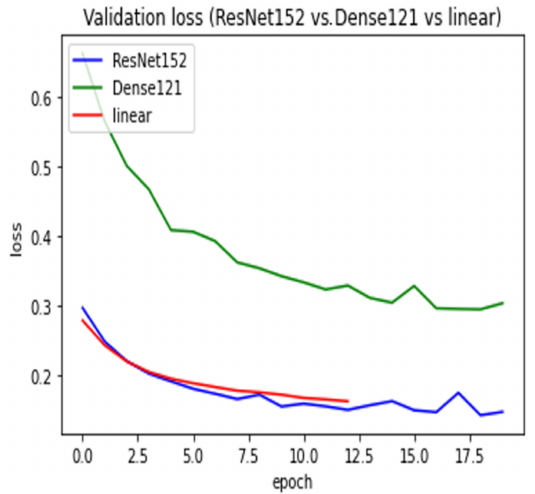
Figure 21. Validation Loss curves for ResNet152, Dense121, and linear